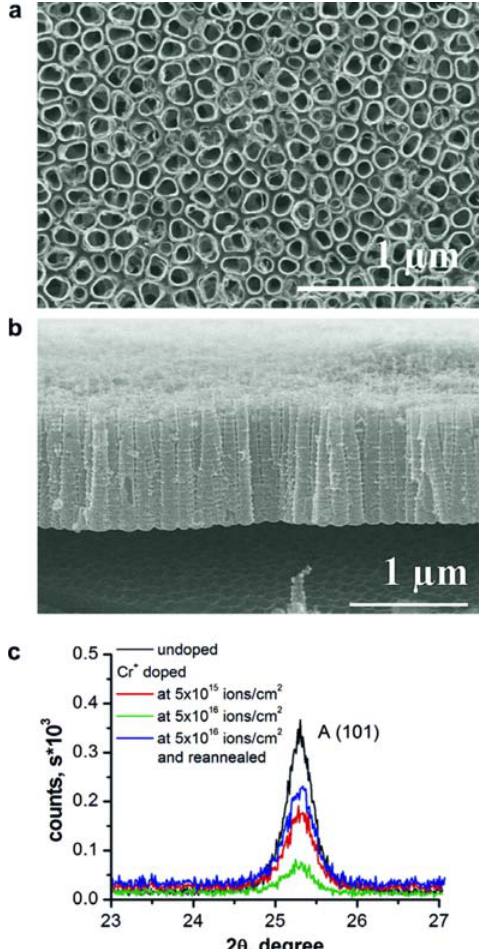
Figure 11. SEM top-view ( a ) and cross-section ( b ) of TiO PO ) + 0.3wt%. HF electrolyte at 20 V for 2 h and subsequent annealed at 450 °C 1M (NaH 2 4 for 1 h, in air, and ( c ) the XRD results (anatase reflex – A) for the undoped samples, Cr + ion implanted at nominal fluence 5  10 15 cm − 2 , 5  10 16 cm − 2 and 5  10 16 cm − 2 with annealing. Reprinted from [60] with permission. Copyright (2013) Elsevier